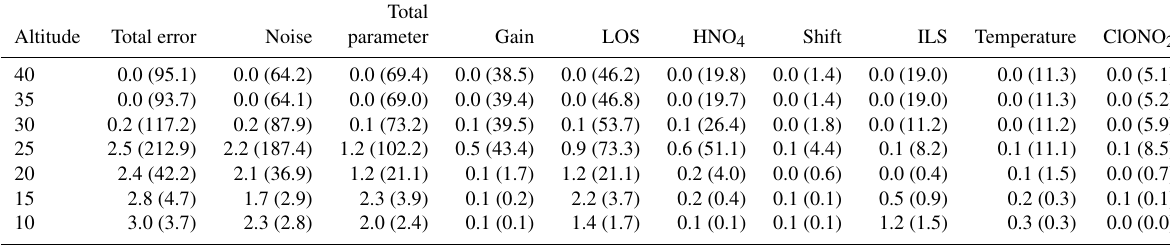
Table A2. Error estimates for a polar summer profile during the FR period. Errors are given in pptv (relative errors in %).